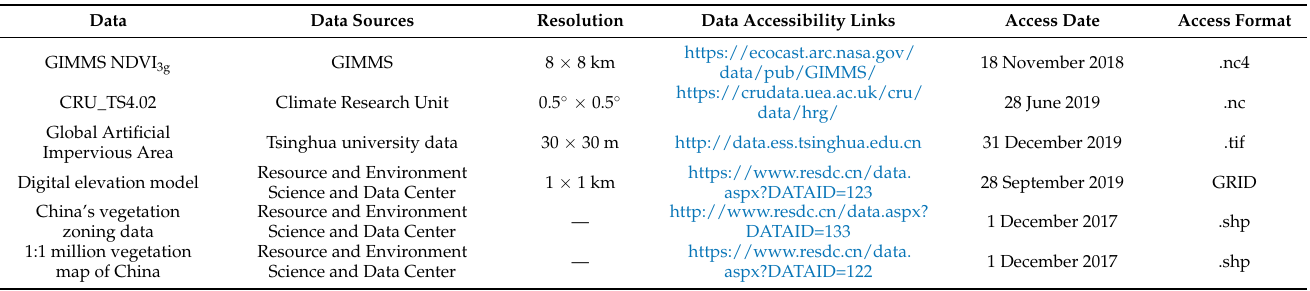
Table 1. The main data